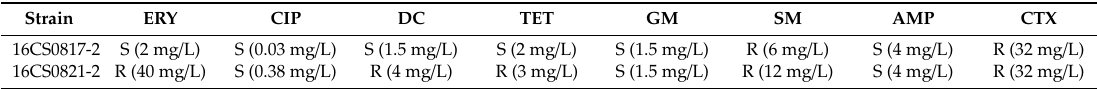
Table 1. Antimicrobial resistance profiles of A. butzleri strains 16CS0817-2 and 16CS0821-2. Strain ERY CIP DC TET GM SM AMP CTX 16CS0817-2 S (2 mg /